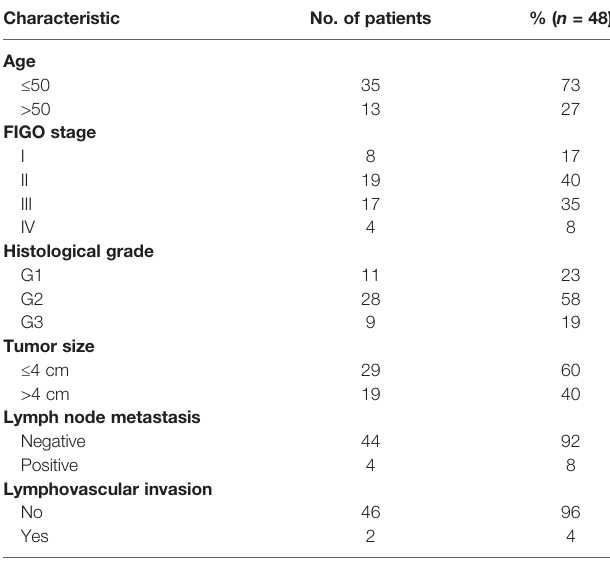
TABLE 1 | Clinicopathological characteristics of patients with cervical cancer.